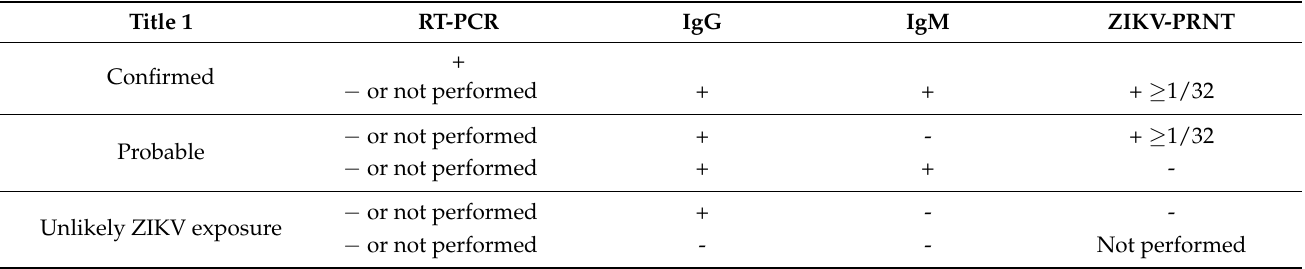
Table 1. Classification of laboratory ZIKV diagnosis for pregnant women and their